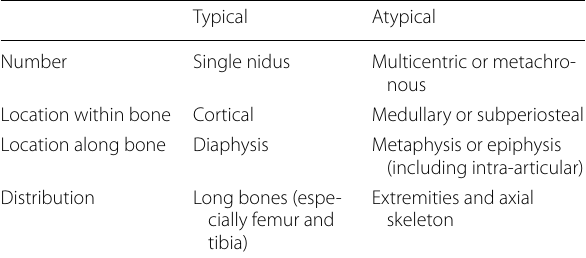
Table 1 OO’s typical and atypical imaging